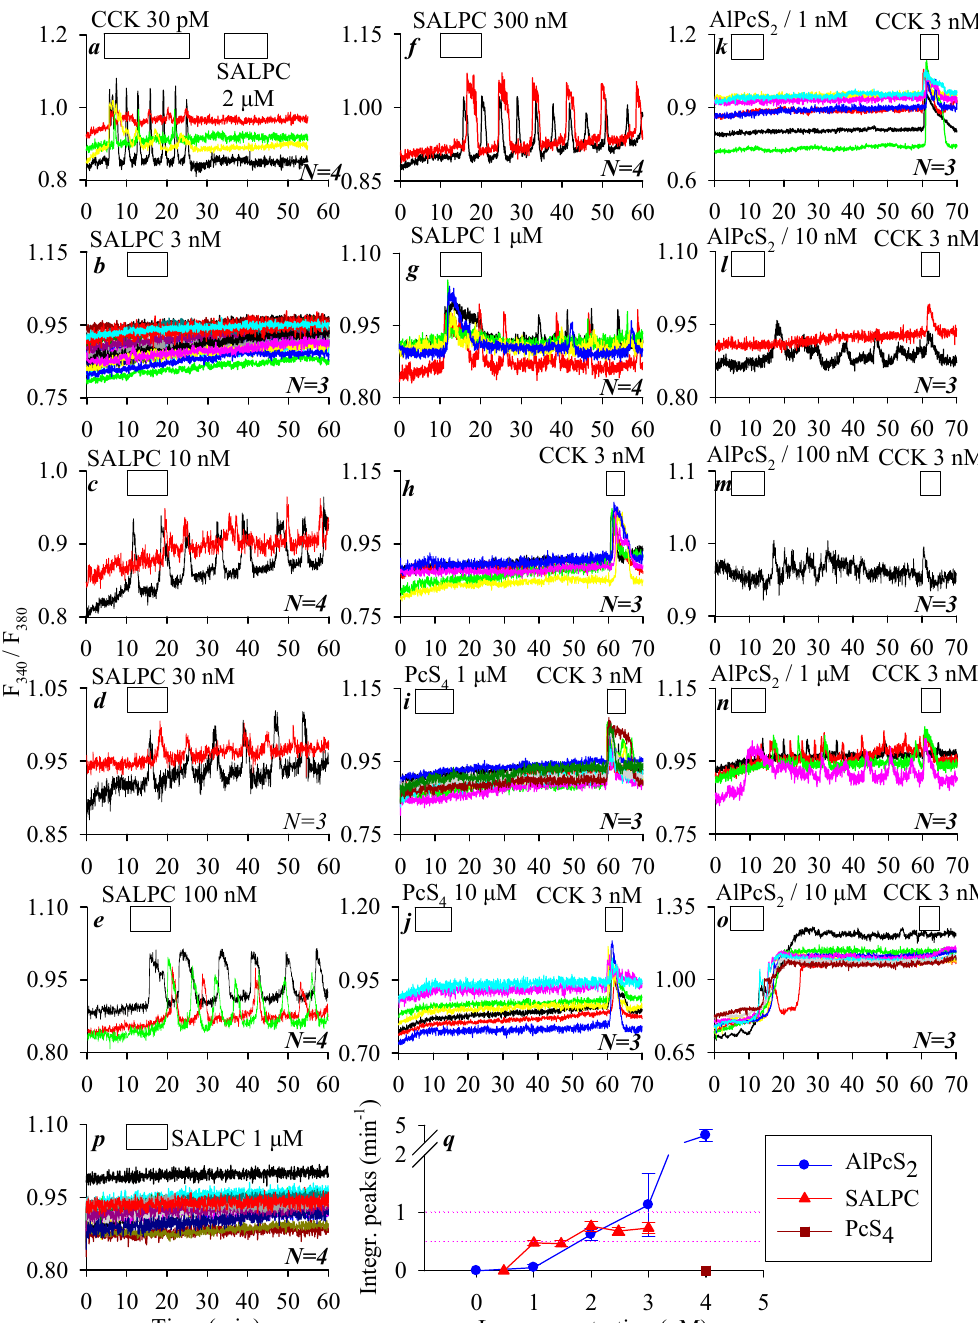
Figure 2. Phthalocyanine molecules SALPC (AlPcS 4 ) and AlPcS 2 , but not PcS 4 activated CCK2R in the dark to trigger calcium oscillations in CCK2R-CHO-K1 cells. CCK1R-CHO-K1 ( a ), CCK2R-CHO-K1 ( b – o ), and CHO-K1 ( p ) cells loaded with Fura-2 AM were attached to coverslips forming the bottom part of Sykes–Moore chambers and perifused. CCK 30 pM and SALPC 2 µ M ( a ), SALPC 3 nM ( b ), 10 nM ( c ), 30 nM ( d ), 100 nM ( e ), 300 nM ( f ), or 1000 nM ( g ); CCK 3 nM ( h ); PcS 4 1 µ M ( i ); PcS 4 10 µ M ( j ); AlPcS 2 1 nM ( k ); AlPcS 2 10 nM ( l ); AlPcS 2 100 nM ( m ); AlPcS 2 1000 nM ( n ); or AlPcS 2 10,000 nM ( o ) plus CCK 3 nM ( i – o ), or SALPC 1 µ M ( p ) were added as indicated by the horizontal bars. Note the lack of any e ff ect of SALPC 1 µ M on parental CHO-K1 cells not transfected with CCK2R ( p ). Quantitative analysis was done for the experiments shown in ( b – o ), and the calculated peak area above baseline is presented ( q ). Representative calcium tracings from one of N identical experiments ( N = 3–4) are shown in ( a – p